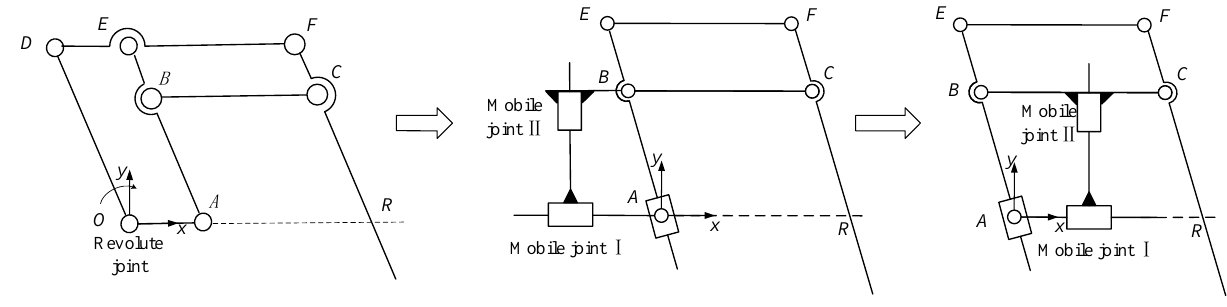
Figure 1. Deduction of planar 2-DOF RCM mechanism.